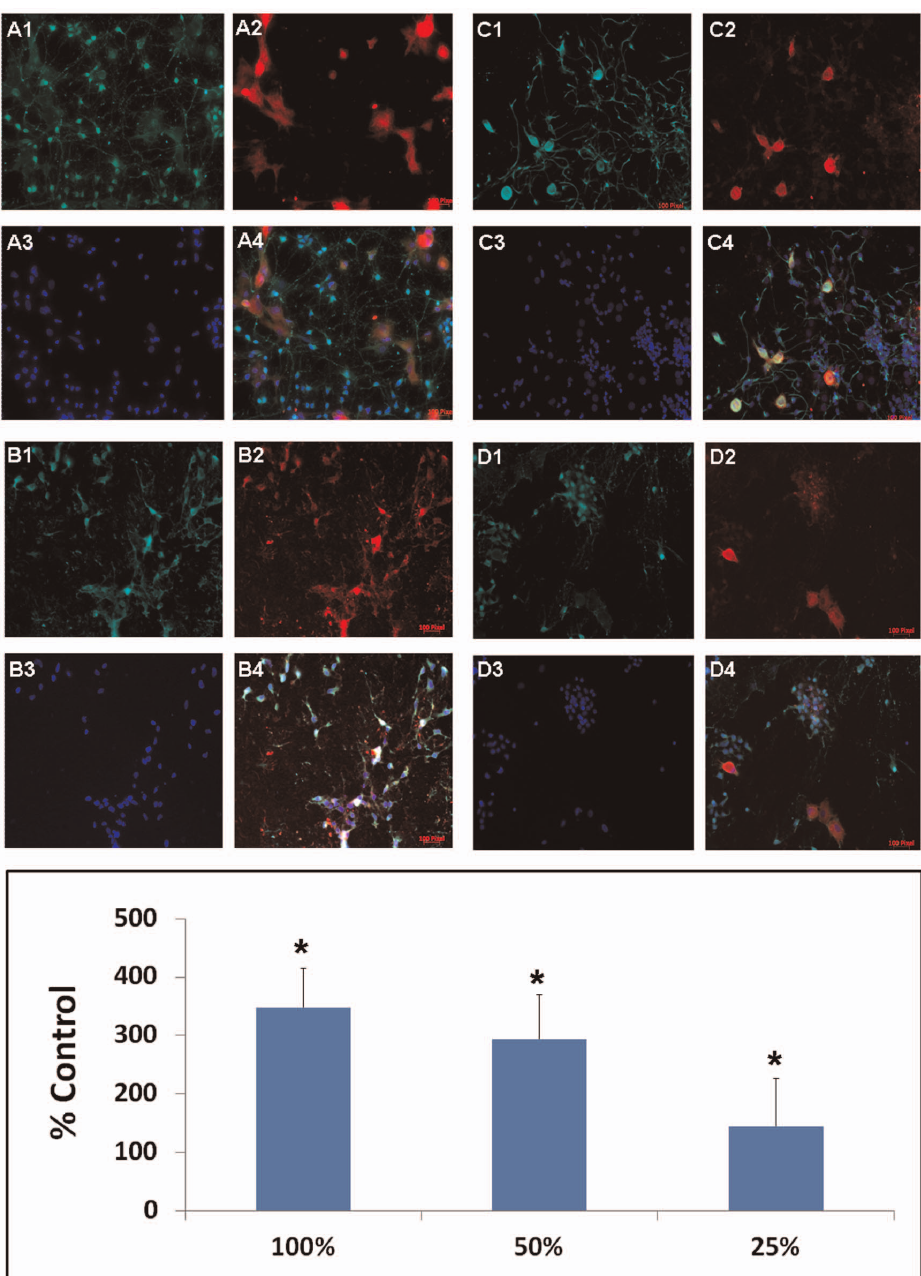
Figure 7. DPCs target Hsp27 for neuroprotection in vitro. Significantly elevated levels of Hsp27 expression were detected in OGD-exposed primary rat neural cells co-cultured with DPCs, which was most pronounced in GFAP-positive cells showing dose-dependent expression of Hsp27 (*p , 0.05 vs. controls, i.e., 0%). A: 100% dose; B: 50% dose; C: 25% dose; D: 0% dose; 1: GFAP; 2: Hsp27; 3: DAPI; 4: Merged.